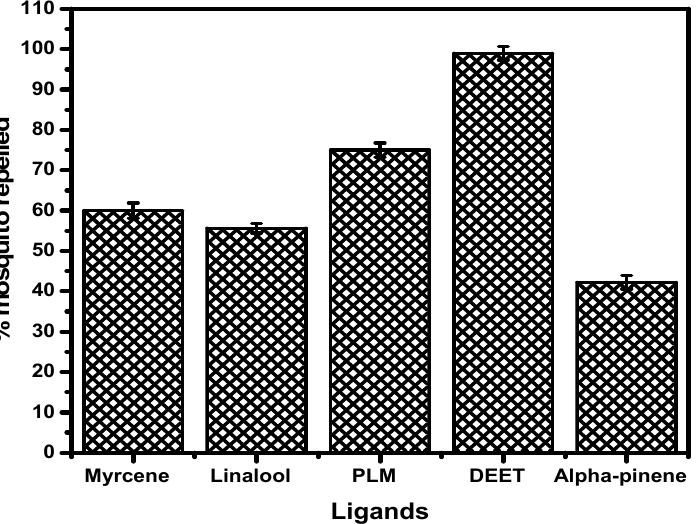
Figure 15. Percentage mosquito repellence test of commercially available main ligands, PLM, and DEET after exposure for 30 min.